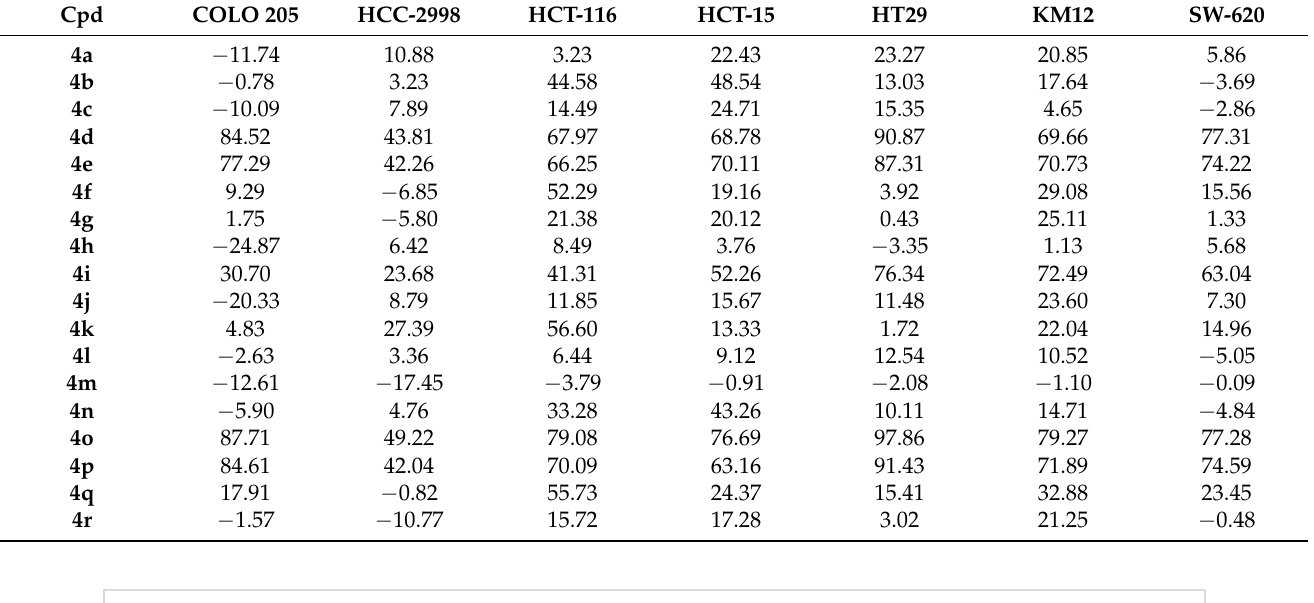
Table 7. Anti-proliferative activities (% growth inhibition) of the target compounds 4a – r against colon adenocarcinoma cell lines.